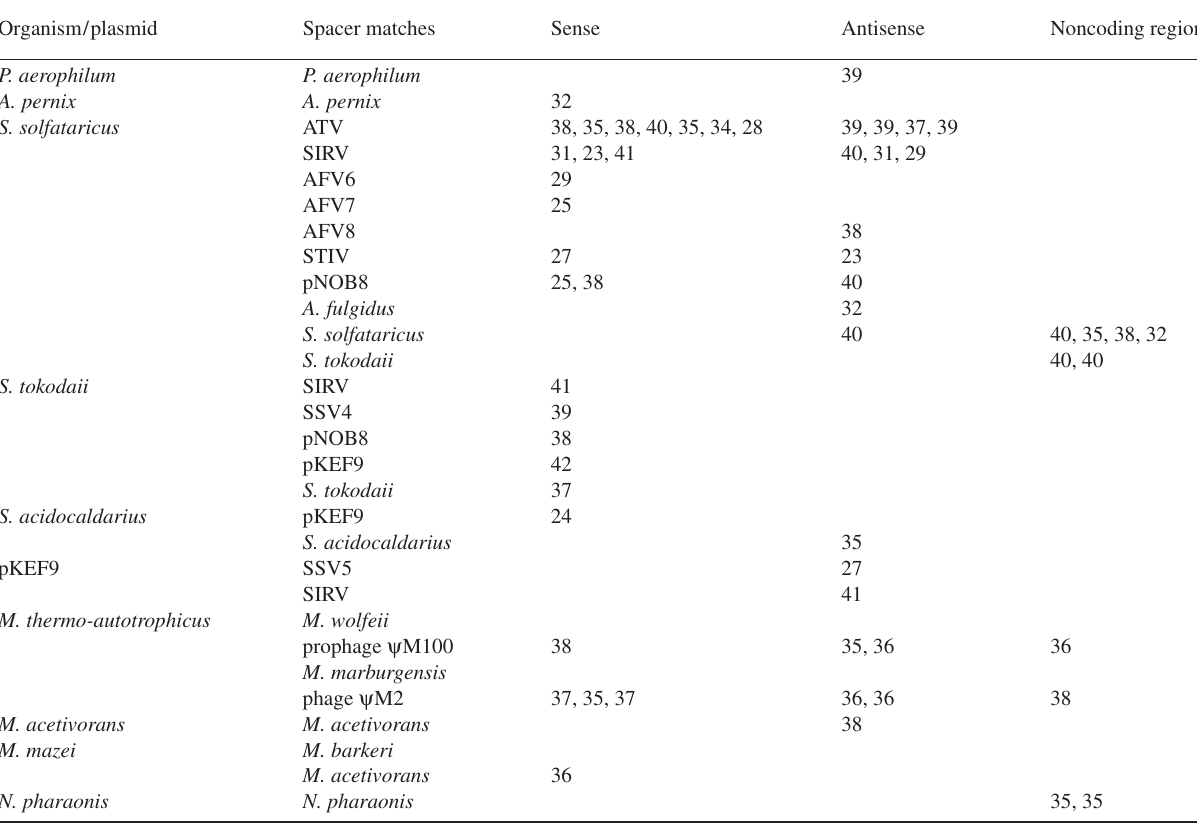
Table 6. Spacer sequence matches to viruses, plasmids and chromosomes. Lengths of the sequence matches are given in columns 3–5 where se- quence identity ranged from 88 to 100%. For transposase genes only the best match is given. For M. thermoautotrophicus , there were three matches to phage ψ M2 ORF6 and two to prophage ψ M100